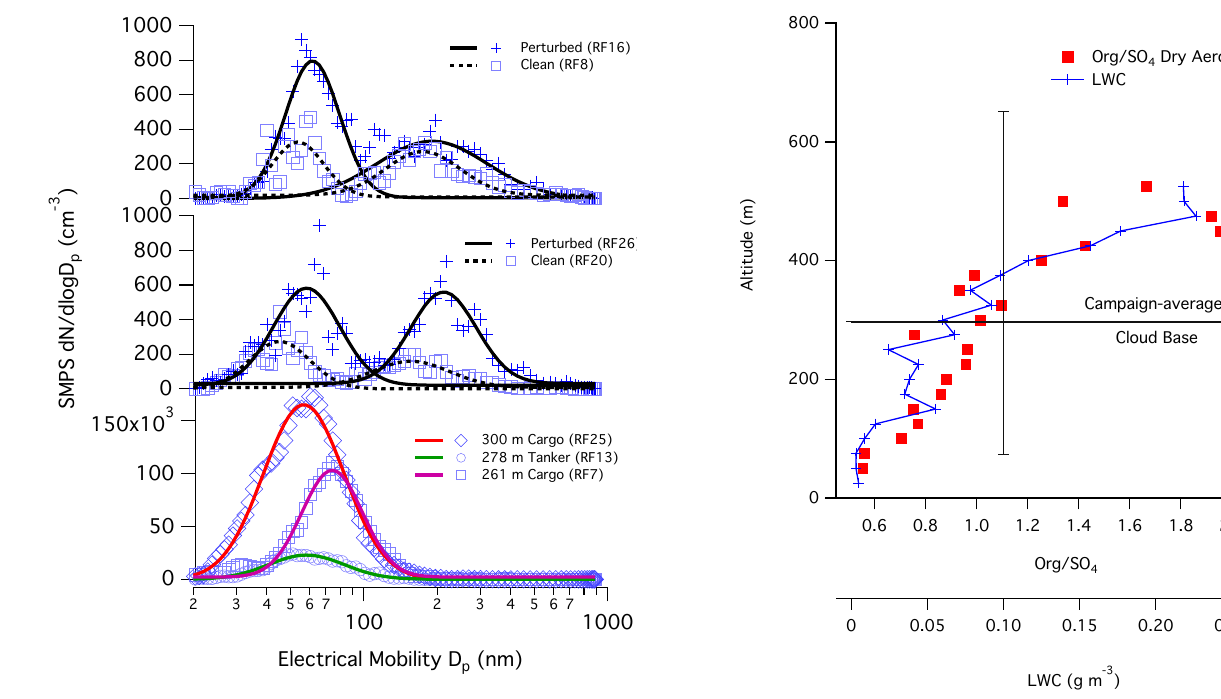
Fig. 4. Average organic:sulfate mass ratio of dry, unperturbed ma- rine aerosol sampled in cloud-free air as a function of altitude. For clarity, standard deviations bars are omitted, however we note that variation increased with altitude. Average LWC is presented to il- lustrate the study-averaged, below-cloud top liquid water profile and show that cloud processing was prevalent at all altitudes. The campaign-average cloud base is shown with bars depicting the range of cloud bases and tops observed during the campaign. Cloud base altitudes were measured during aircraft